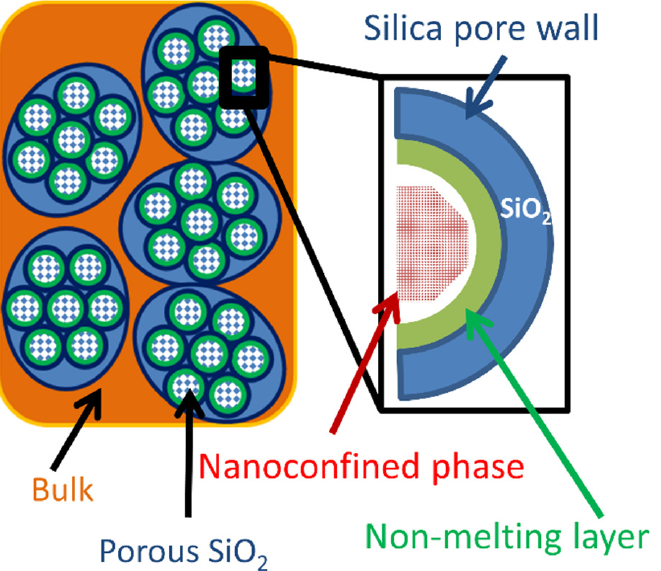
Figure 4. Schematic representation of porous silica composite PCMs showing the non-melting layer, bulk and nanoconfined phases.